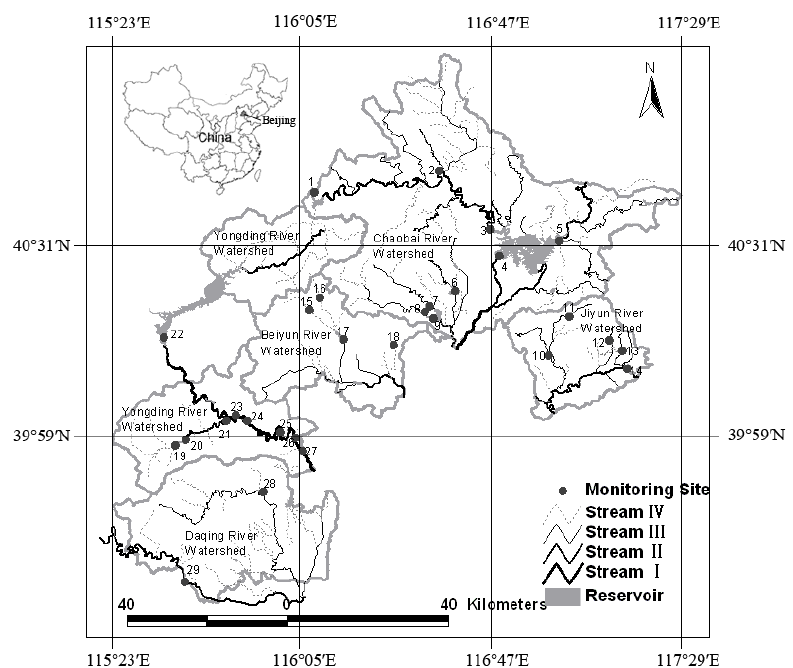
Figure 1. Study area and monitoring